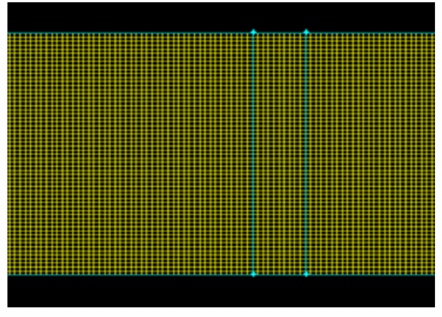
Figure 2. Mesh local.